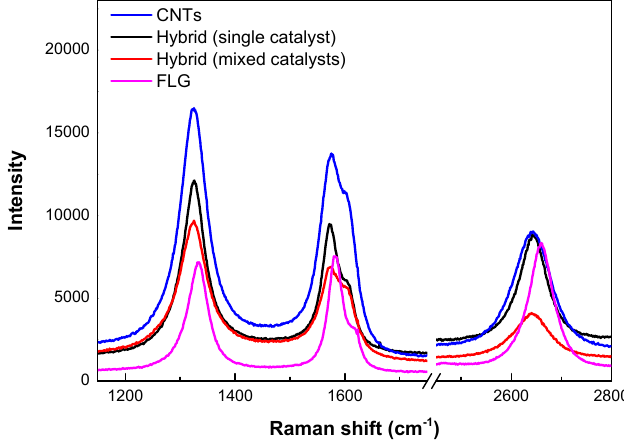
Table 1. Full width at half maximum (FWHM) for D, G and G’ bands, and I D / I G and I G / I G’ ratios from